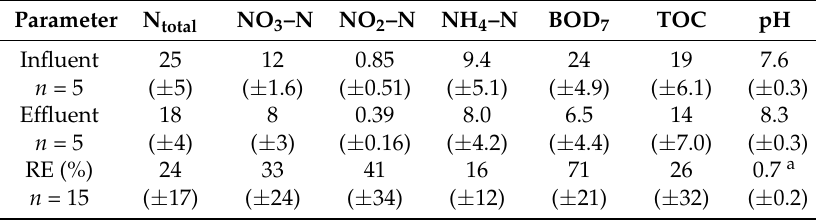
Table 1. The means and standard deviations (in parentheses) of wastewater parameters (mg/L, except for RE and pH) of horizontal subsurface flow mesocosms (HSSF MCs), removal efficiencies (RE), and pH differences ( a ) between influent and effluent of HSSF MCs during the 150-day study period. TOC, total organic carbon; BOD 7 , seven-day biochemical oxygen